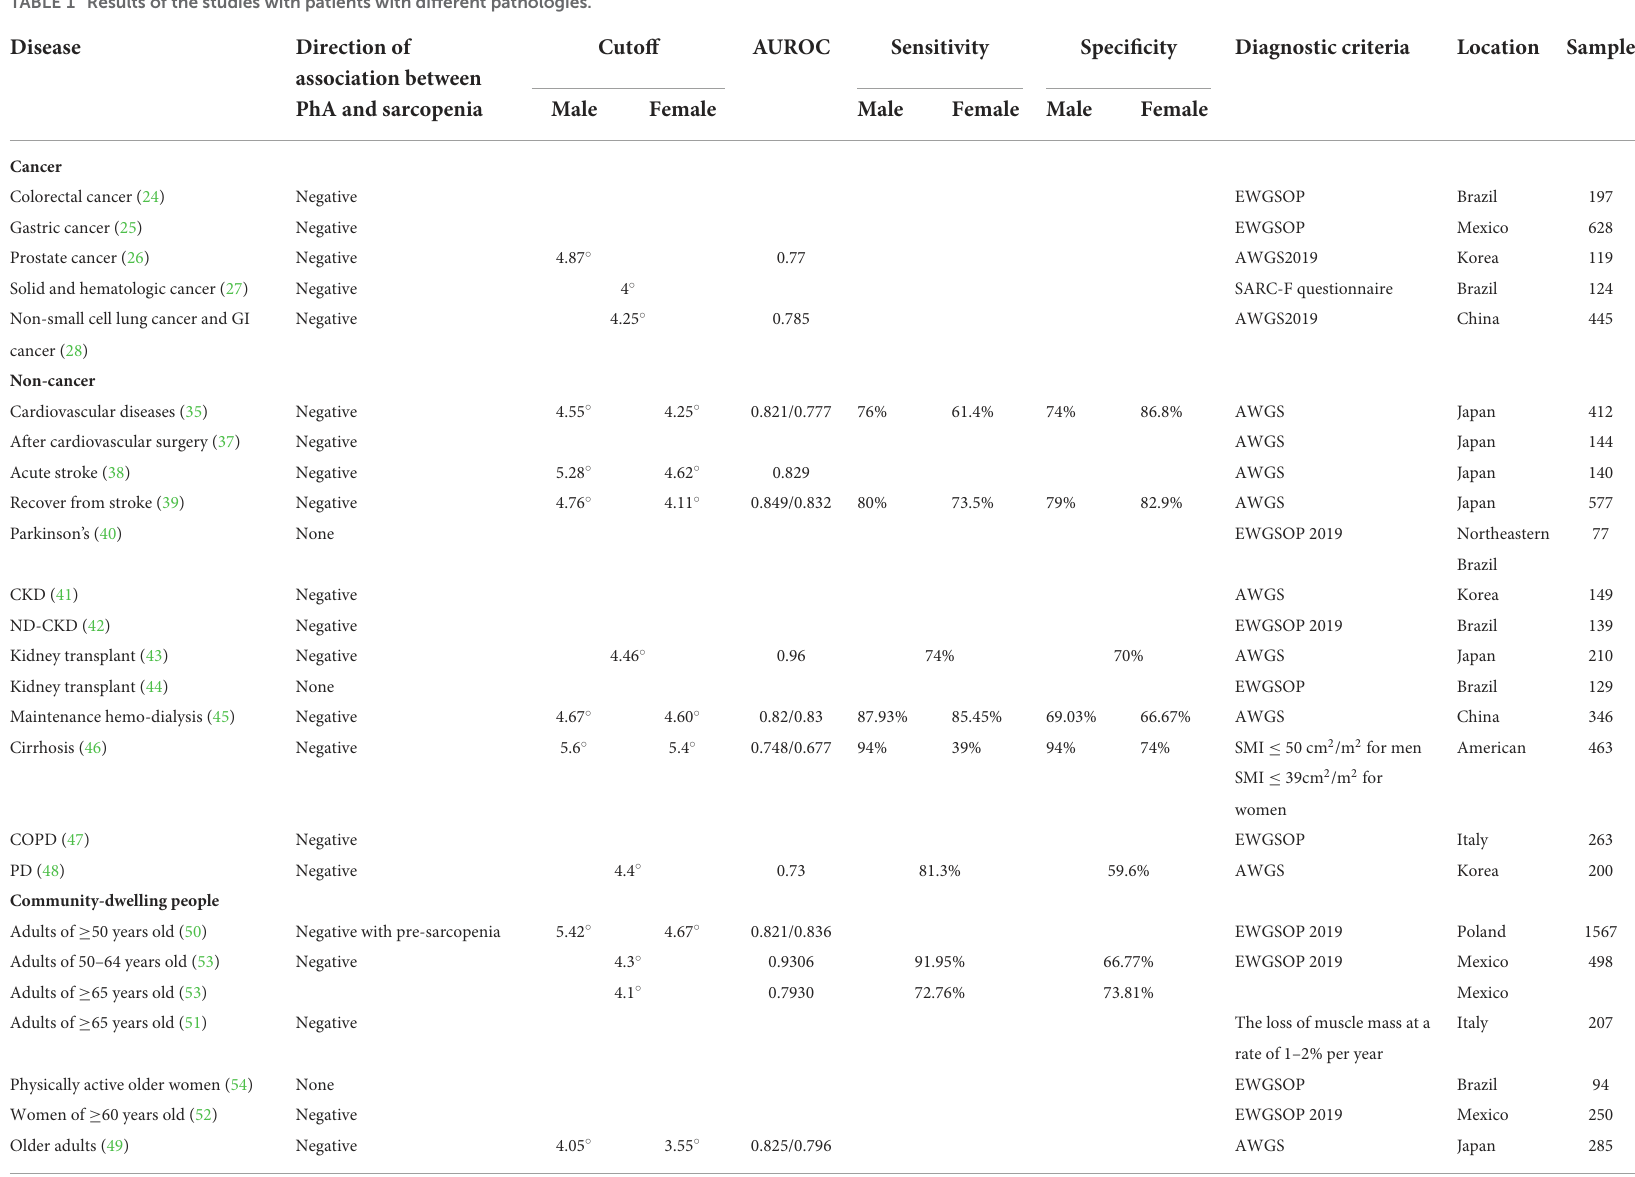
TABLE 1 Results of the studies with patients with different pathologies. Disease Direction of association